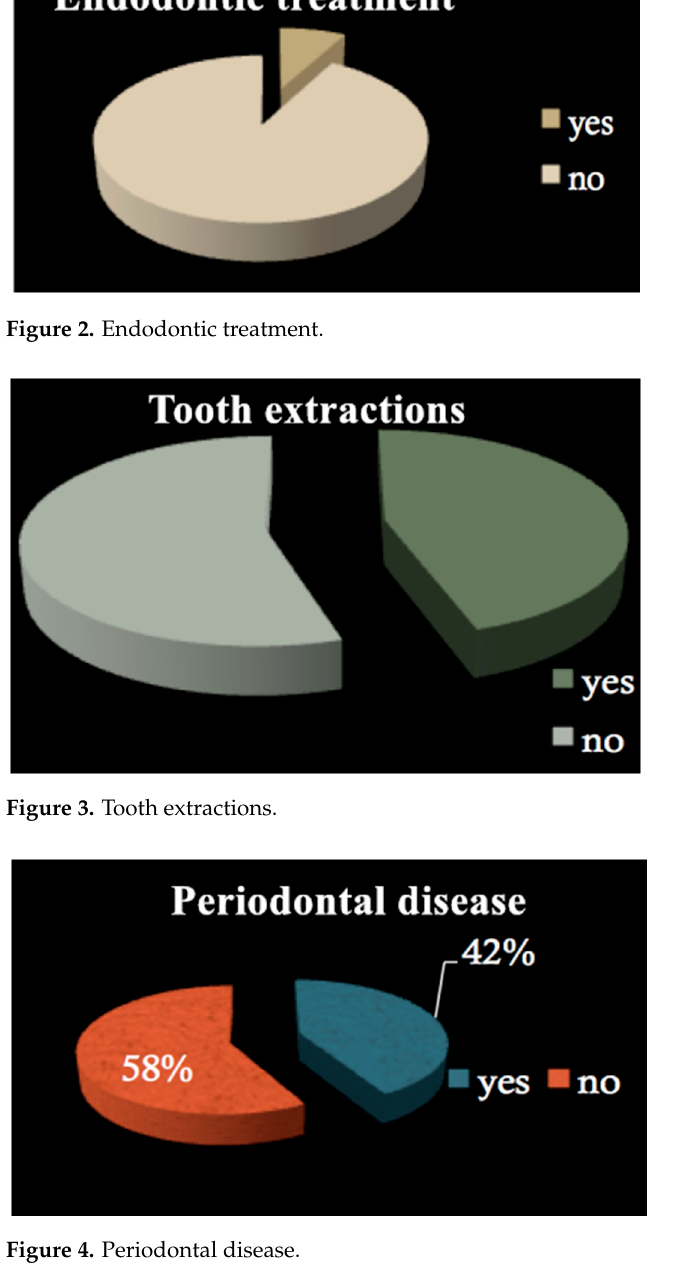
Figure 1. Restorative therapy.